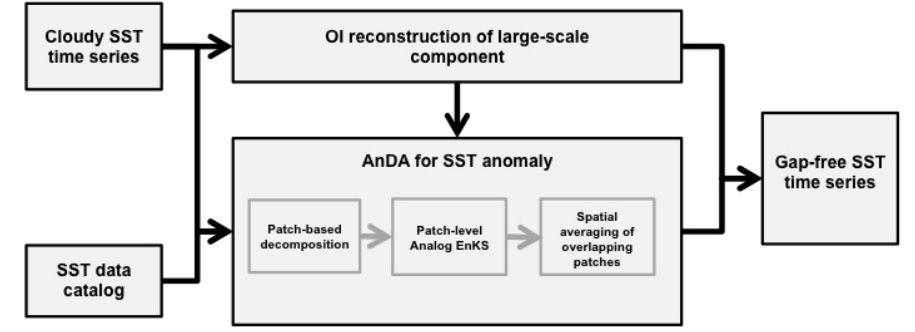
Figure 2. Workflow of the proposed framework for the reconstruction of gap-free SST time series from cloudy SST data: given a cloudy SST field time series, it first applies an optimal interpolation to reconstruct the large-scale component (cid:98) X and second the analog data assimilation (AnDA) of the anomaly dX (cf. (Equation (1))). This second step exploits a reference SST catalog and is constrained by the reconstructed large-scale component. The resulting gap-free SST time series is the sum of the large-scale component (cid:98) X and of the anomaly dX . We also sketch the main steps involved in the AnDA